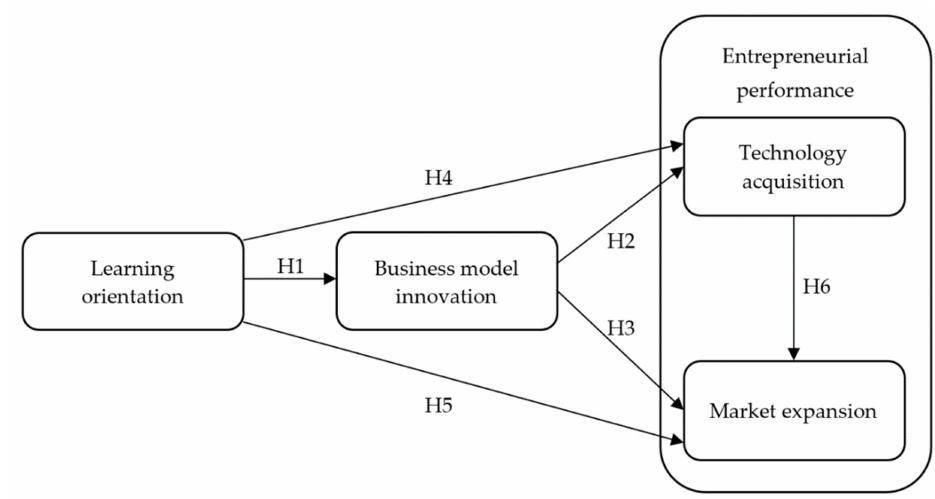
Figure 1. Research model.